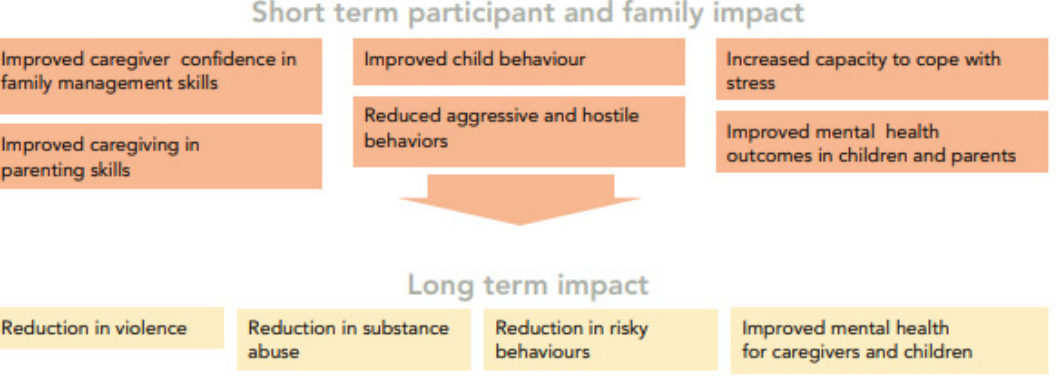
Figure 1. Logic model of the Strong Families programme [38].